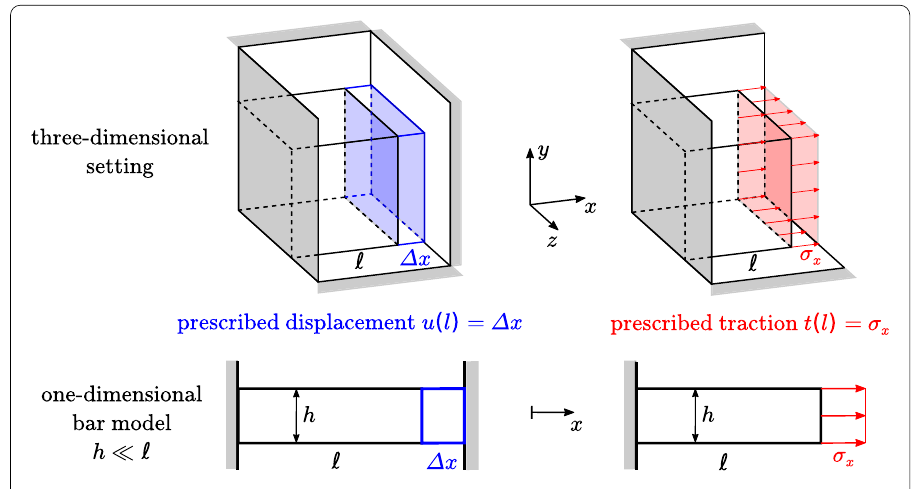
Fig. 2 Relation of investigated one-dimensional verification examples to their respective three-dimensional solid mechanics problem